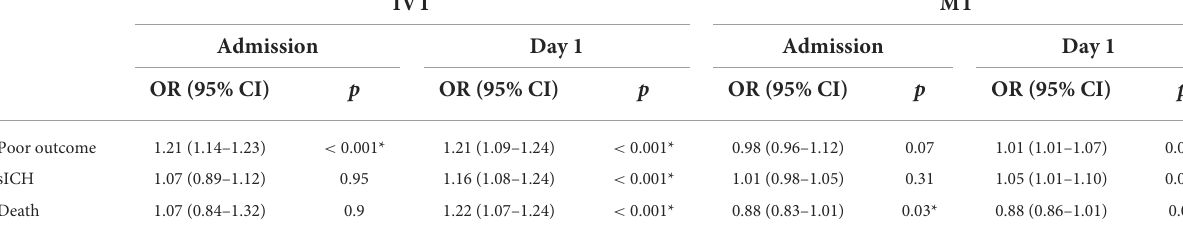
TABLE 6 Unadjusted multivariate analysis for neutrophil–lymphocyte ratio (NLR) prediction models.